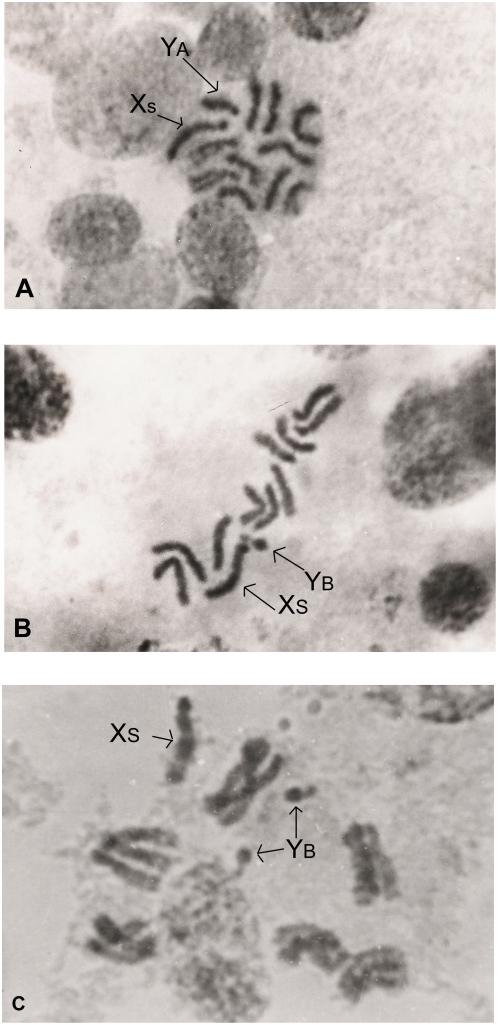
Mitotic metaphase plates of different specimens of the ARG 17strain.(a) An XSYA male. (b) An XSYB male. (c) A triploid XSYBYB male, 4000×.